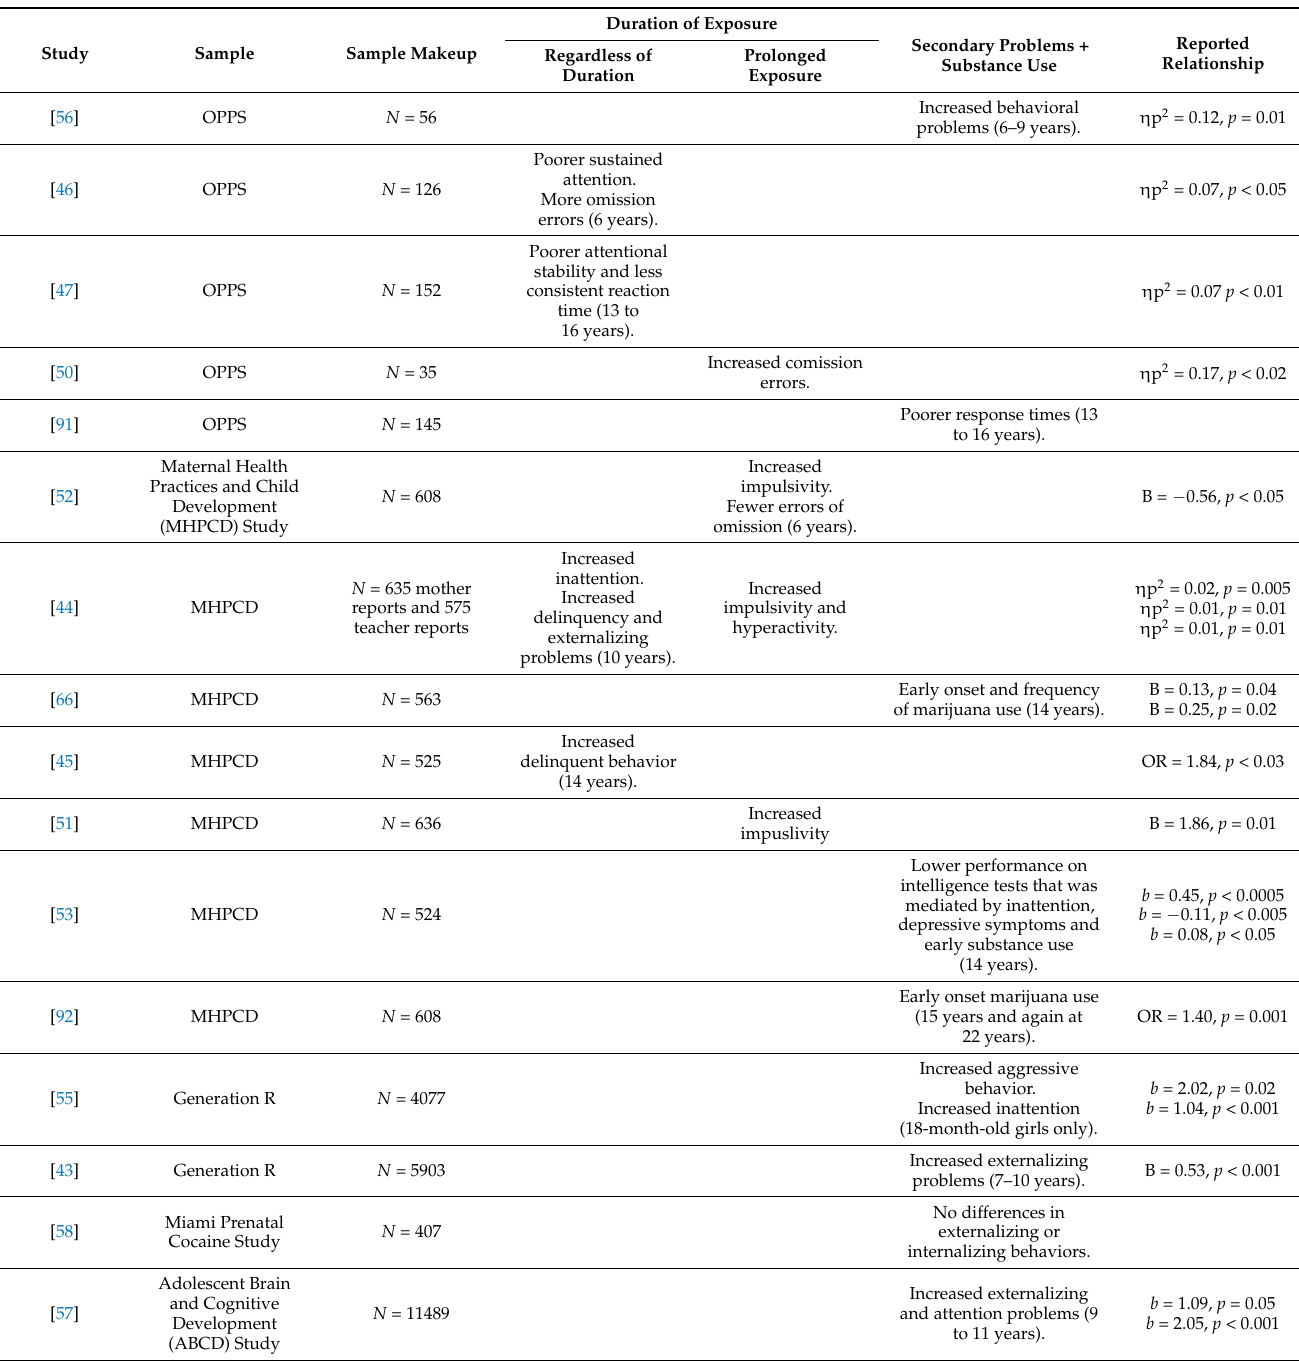
Table A1. Reported Effects of Prenatal Cannabis Use on Developmental